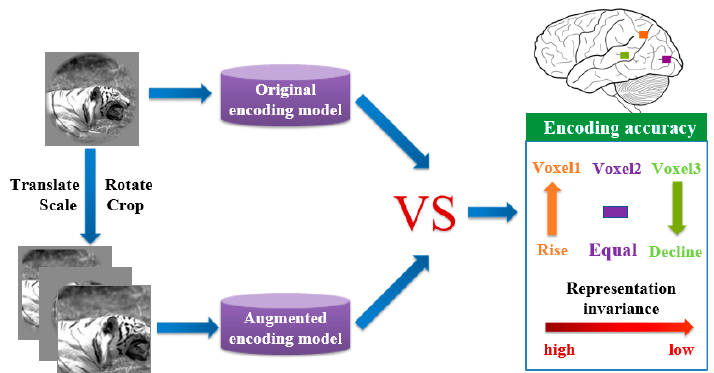
Figure 3. An analysis method of human visual invariance based on the fMRI visual encoding model. The original encoding model and augmented encoding model are trained by the original image library and data augmentation image library respectively. Prediction accuracies of each voxel predicted by the two models were compared. If the prediction accuracies of voxel 1 (orange), voxel 2 (purple), voxel 3 (green) rise, remain unchanged, and decline, respectively, there will be a decreasing tendency of representation invariance from voxel 1 to voxel 3.